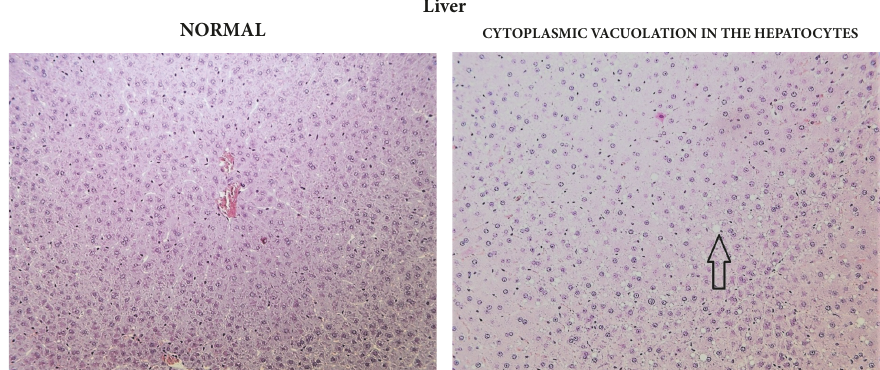
Figure3:Liver:comparisonofnormal(control)tissuetohepatocytesofamalefromthe3000/4000mg/kgbw/daygroupshowingcytoplasmic vacuolation, 14-day study.